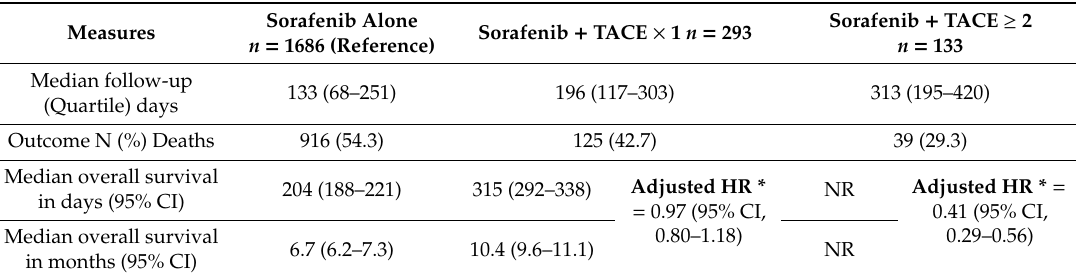
Table 4. Survival outcome of sub-cohorts stratified by the number session of additional transarterial chemoembolization (TACE), administered once-only versus two or more sessions, when compared with the sorafenib-alone